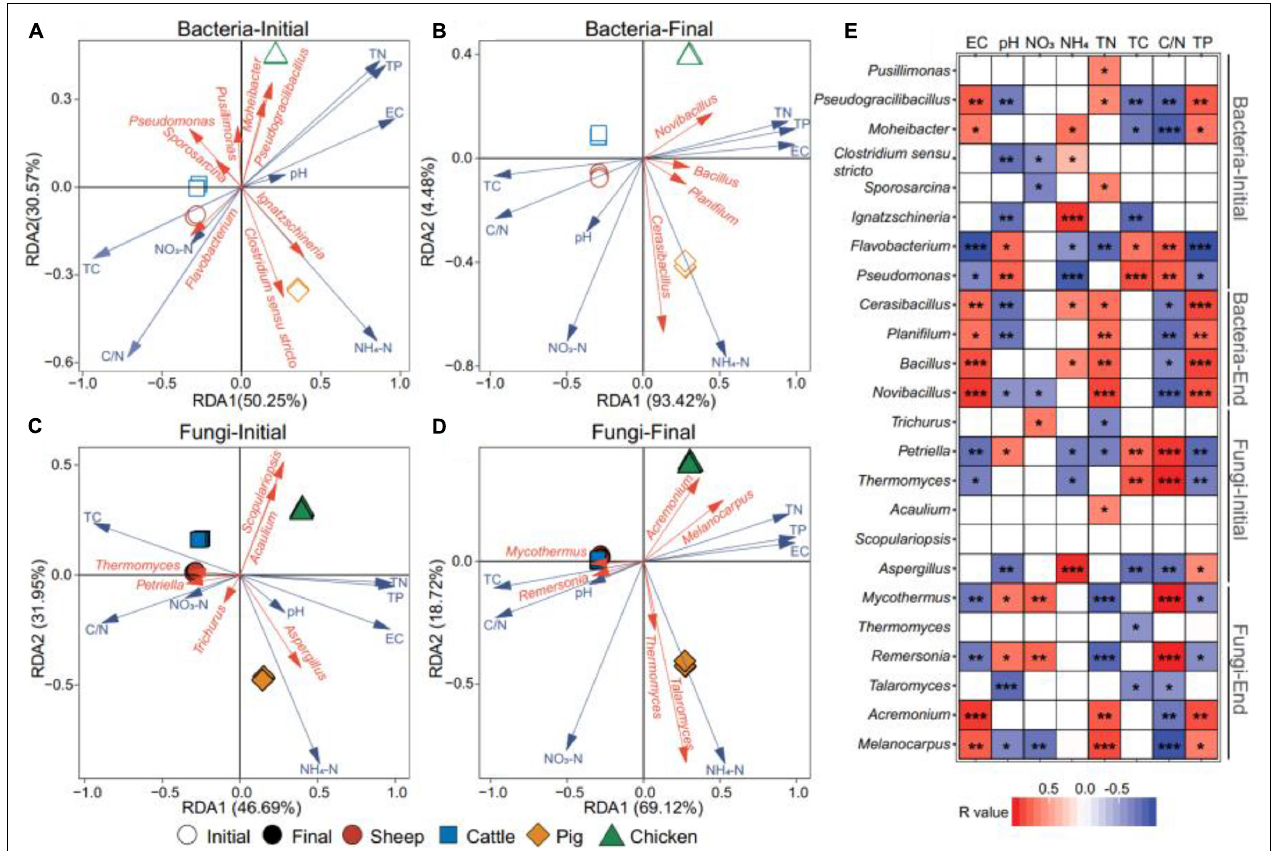
FIGURE 4 | Correlations between physiochemical compost properties and microbial abundances based on redundancy analysis (RDA). Panels (A,B) show the relationship between bacterial and fungal genera with physicochemical composting properties (pH, EC, NH 4 -N, NO 3 -N, TC, TN, C/N, and TP) at the initial and final phases of composting. Panels (C,D) show the same relationship between fungal genera and physicochemical compost properties. In panels (A–D) , red vectors show the genera with > 2% relative abundance, while blue vectors show compost physicochemical properties. Panel (E) shows Spearman correlation analysis between bacterial and fungal genera and compost physicochemical properties, where r > 0 denotes for positive correlations (red) and r < 0 for negative correlation s (blue); *, **, and *** denote for P values lower than 0.05, 0.01, and 0.001, respectively. N = 3 for each type of manure compost.